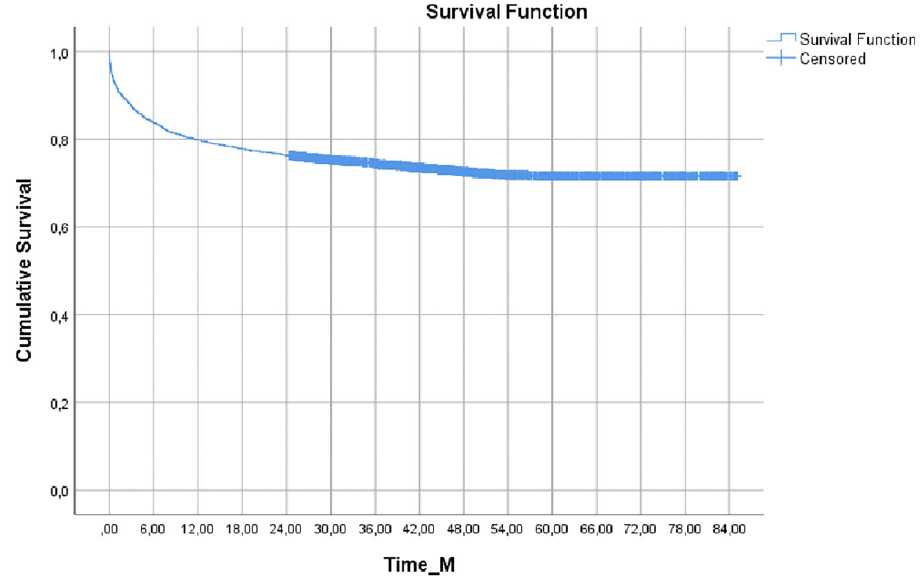
Fig 1. Cumulative survival of TB/HIV coinfection cases between 2009 and 2013, Porto Alegre, Brazil.